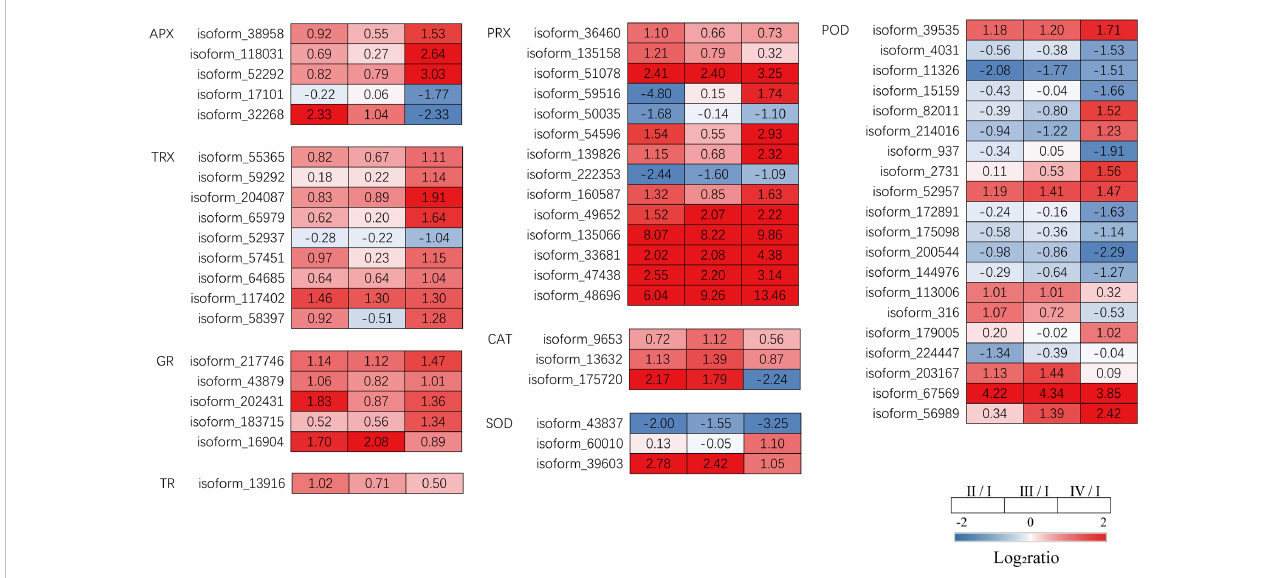
FIGURE 8 The transcriptomic changes with the antioxidant system in the tetraspore formation of G. lemaneiformis between different phases. Red and blue gradients indicate the upregulation and downregulation of unigenes with the adjusted p value<0.001 and |log2ratio|>1, separately, while white represent no signi fi cant